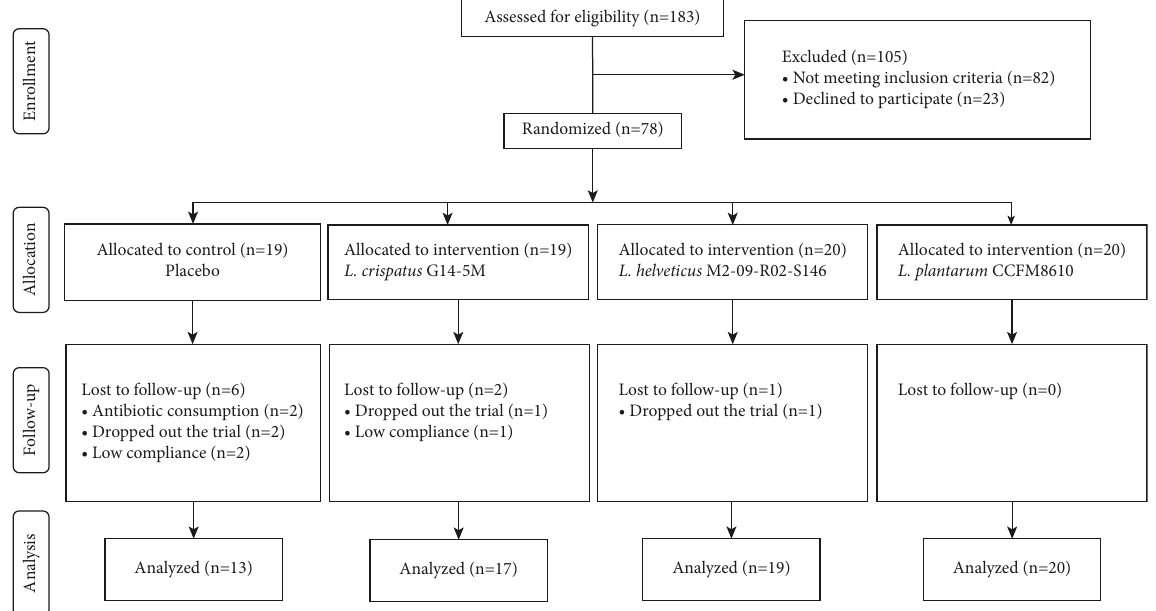
Figure 1: Summary of patient flow in this study. Table 1: General characteristics of